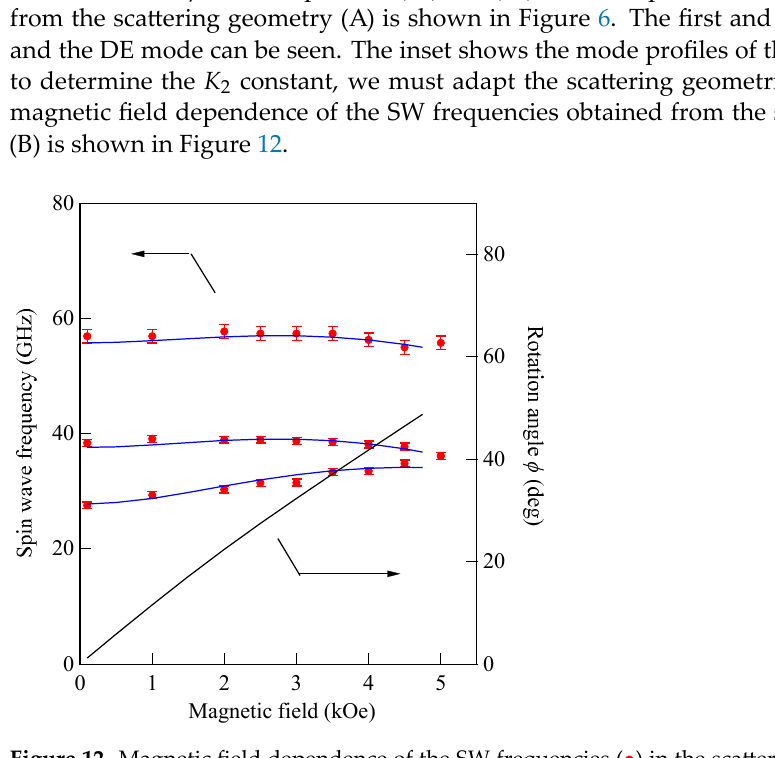
Figure 12. Magnetic field dependence of the SW frequencies ( • ) in the scattering geometry (B). The solid lines were calculated for the SW frequencies ( − ) and the rotation angle ϕ of the magnetization ( − ) using the full magnetic constants given in the text [74].